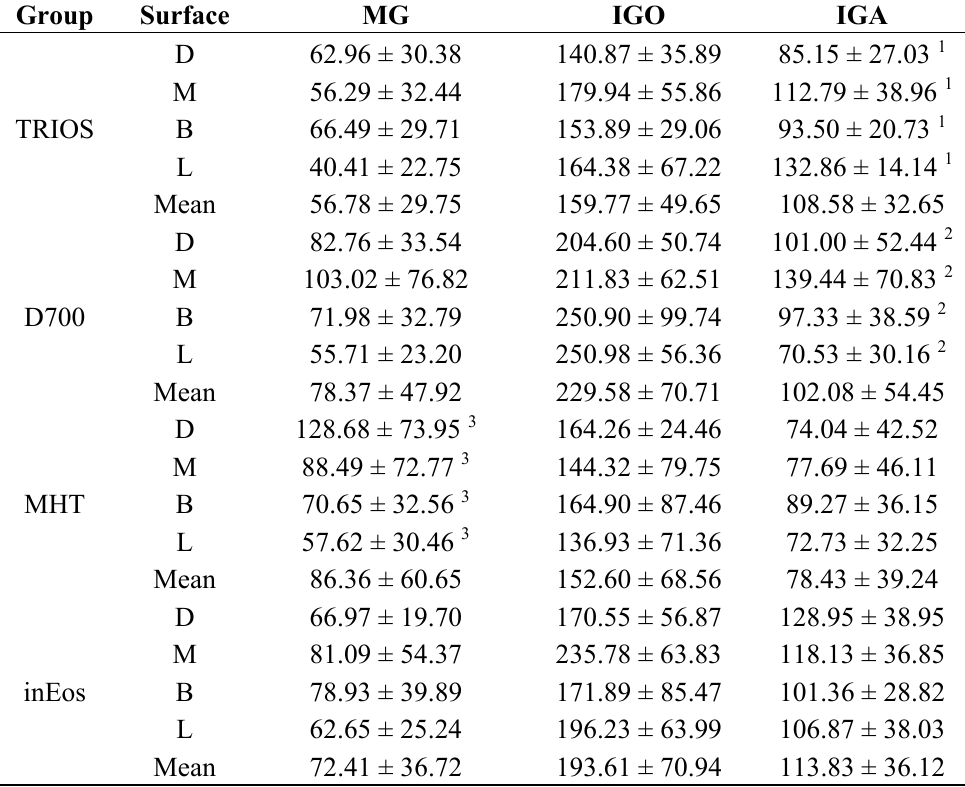
Table 4. Comparison of the marginal, occlusal and axial gaps in distal, mesial, buccal, and lingual surfaces of each group ( μ